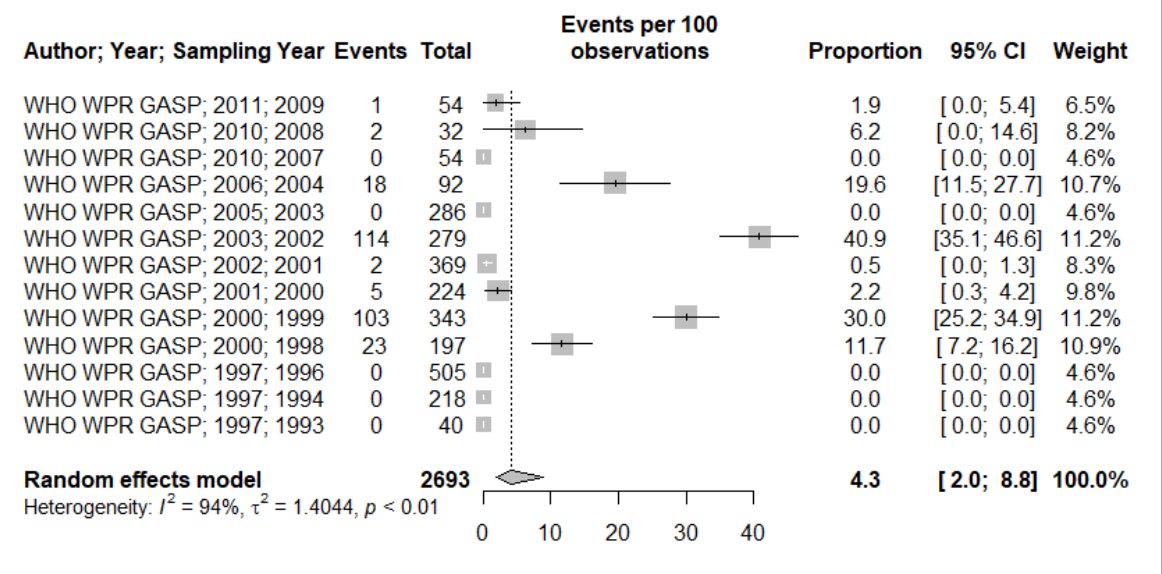
Figure 3. Chromosomally-mediated resistance to penicillin prevalence estimate.